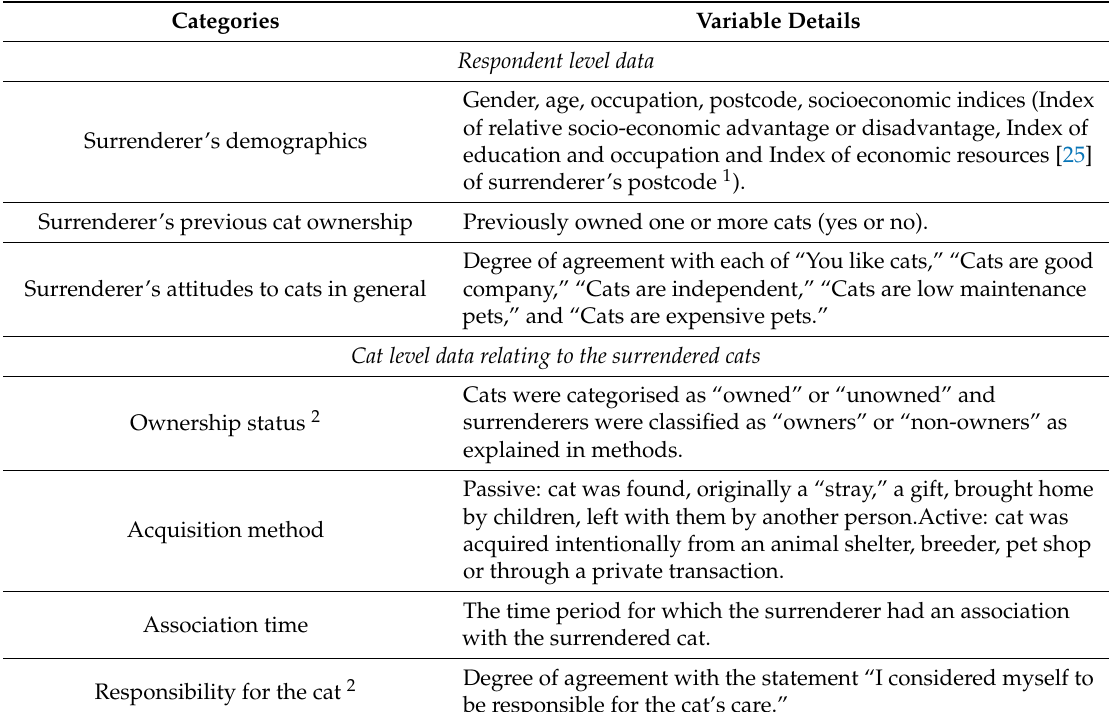
Table 1. Questionnaire categories and data variable